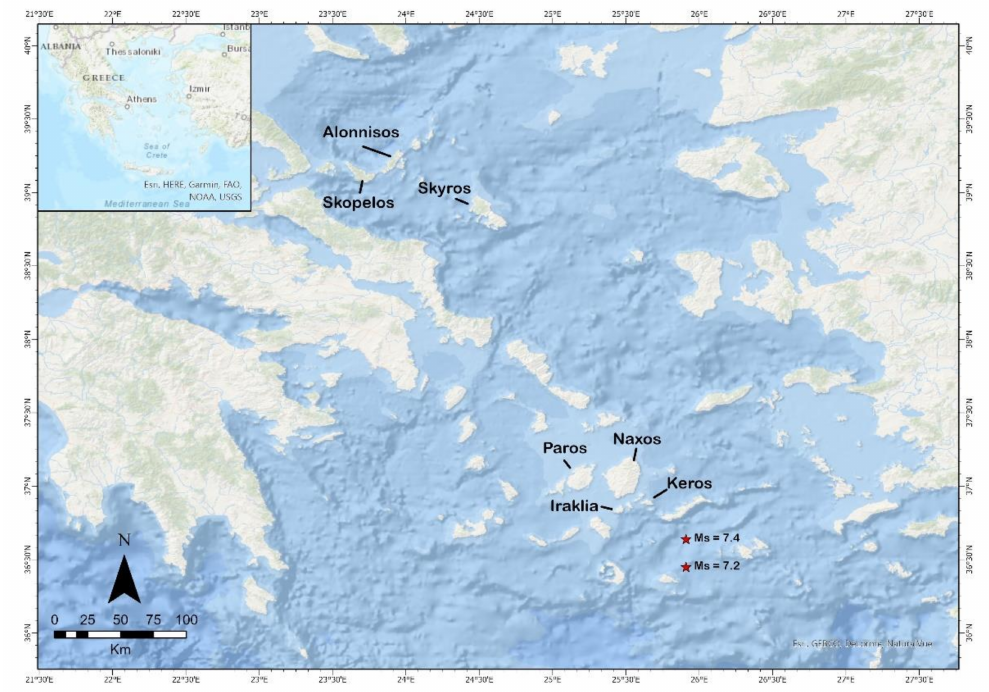
Figure 1. Location map with the studied sites in the Cyclades and Sporades islands. The red stars show the location and magnitude of the 1956 earthquakes, discussed in the